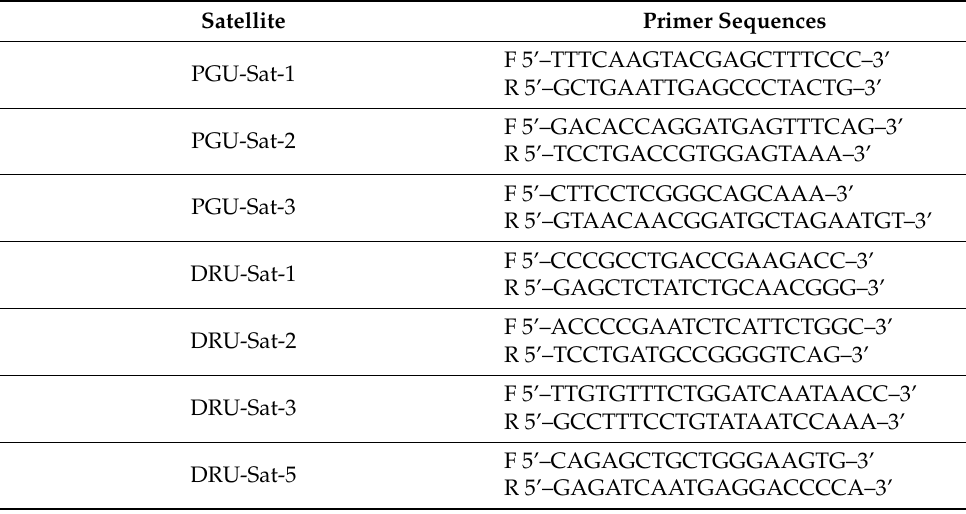
Table 1. Primers used to amplify satDNA in the current